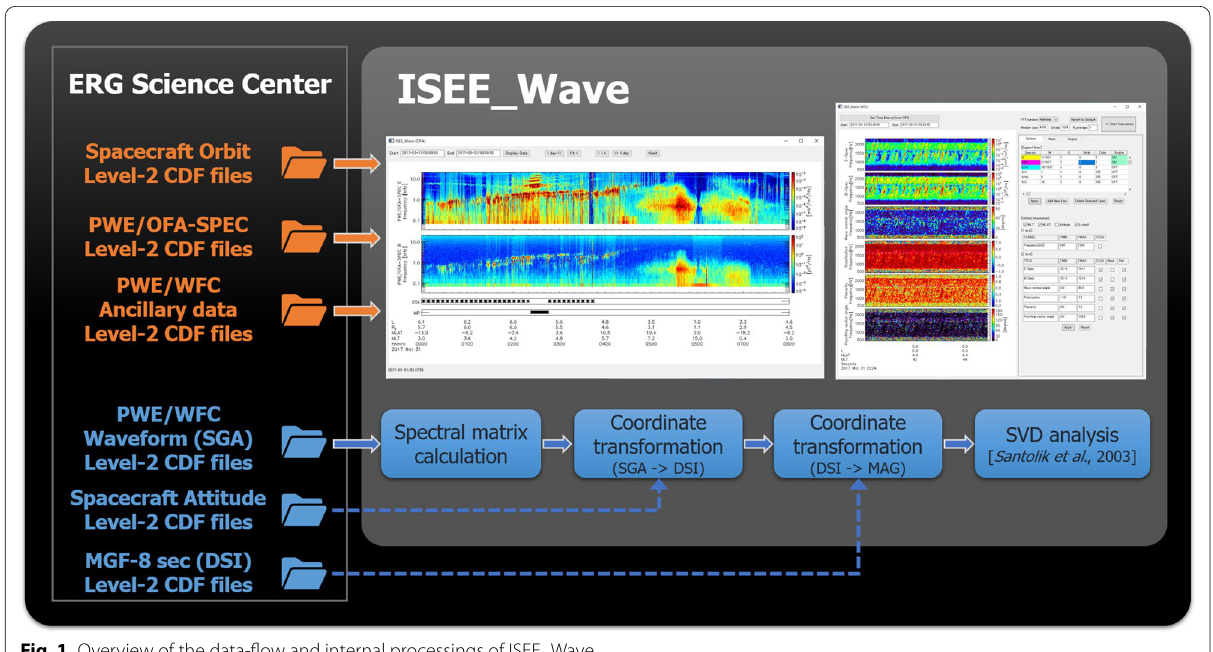
Fig. 1 Overview of the data‑flow and internal processings of